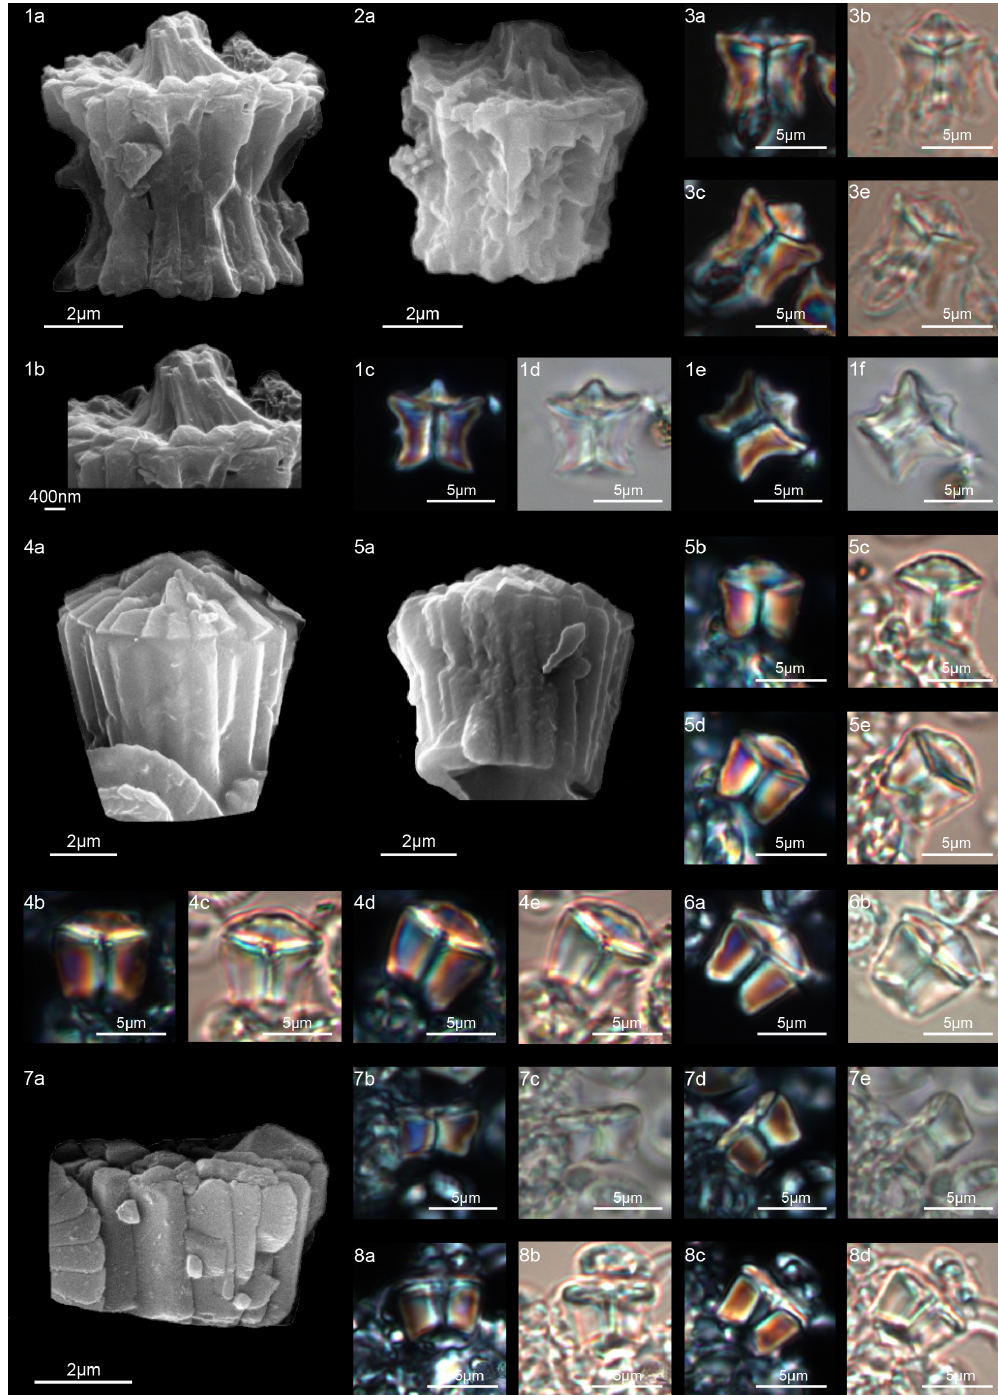
Figure 21. Tectulithus pagodiformis. (1) Holotype (IGF 104726). Sample: 356Z 23R-1, 70–71. (1a) SEM, (1b) SEM, detail of tectum; (1c, e) XPL, (1d, f) PPL. (2) Paratype (IGF 104727). Sample: 356Z 23R-1, 70–71. (2a) SEM. (3) Sample: 356Z 23R-1, 70–71. (3a, c) XPL, (3b, d) PPL. Tectulithus pileatus . (4) Sample: 1262C 10-4, 131–132. (4a) SEM, (4b, d) XPL, (4c, e) PPL. (5) Sample: 1262C 10-4, 131–132. (5a) SEM, (5b, d) XPL, (5c, e) PPL. (6) Sample: 1209B 24-5, 8–9. (6a) XPL, (6b) PPL. Tectulithus stegastos . (7) Sample: 1209C 14-1, 56–57. (7a) SEM, (7b, d) XPL, (7c, e) PPL. (8) Sample: 1209B 24-5, 8–9. (8a, c) XPL, (8b, d) PPL. See Table S1 for sample